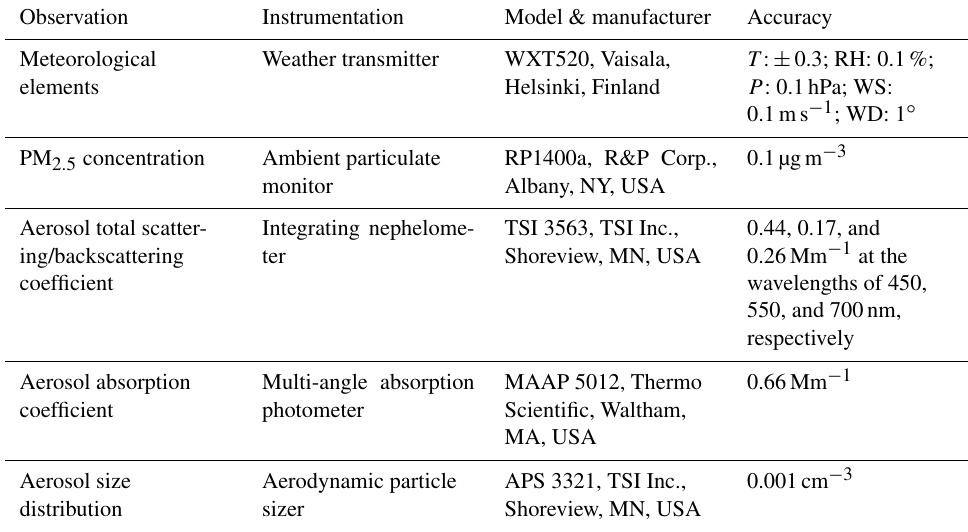
Table 1. The main aerosol observations and ground-based instrumentations at three sites. Observation Instrumentation Model &